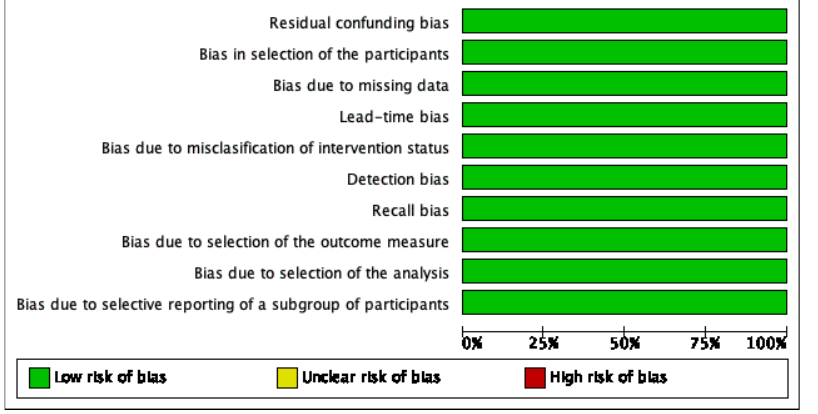
Figure 2. Residual confounding bias: review authors ’ judgments about each risk of bias item presented as percentages across all included studies.